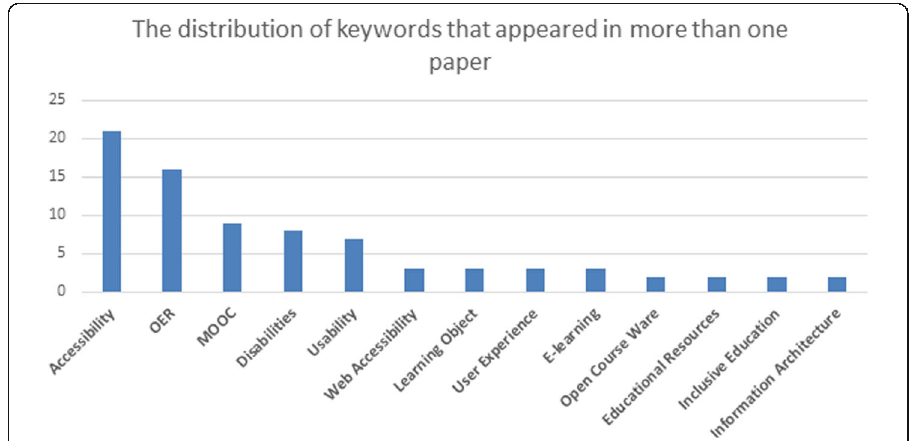
Fig. 4 Distribution of keywords in the reviewed research